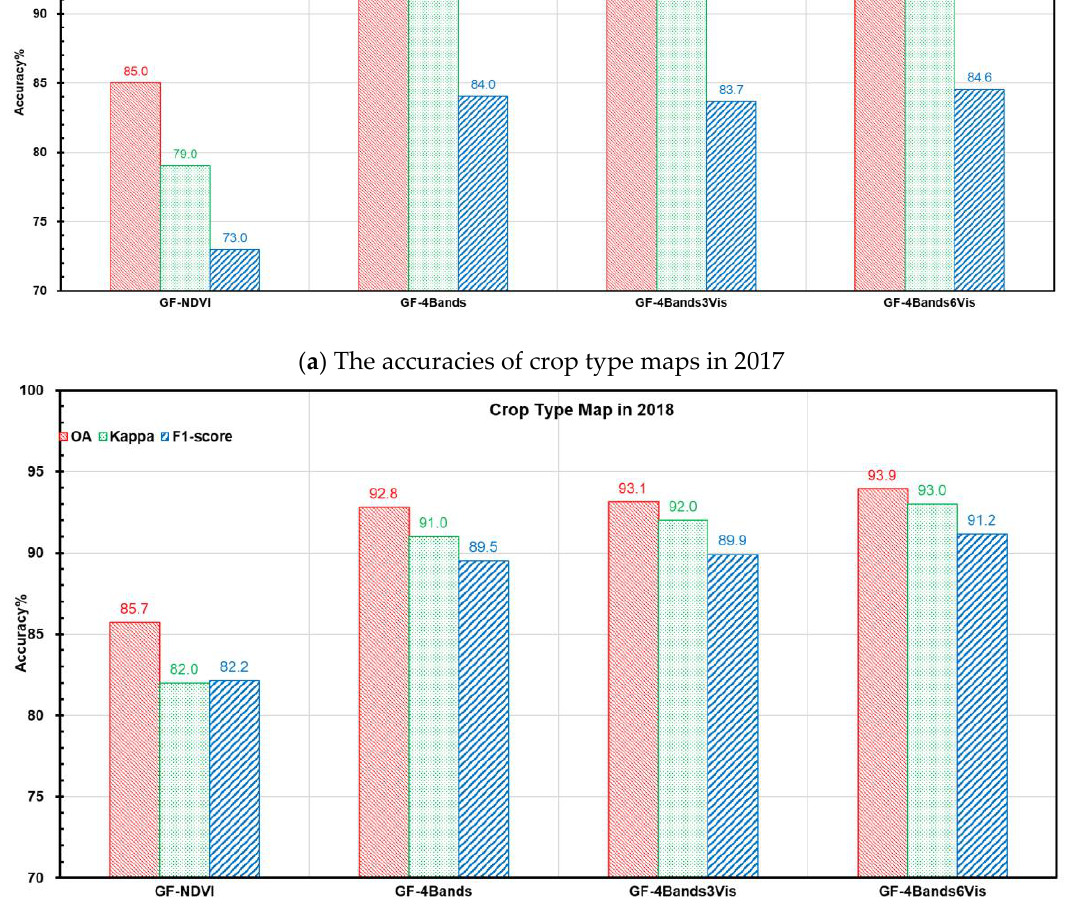
Figure 4. The accuracy improved with an increasing number of features for the GF-1 time series data.